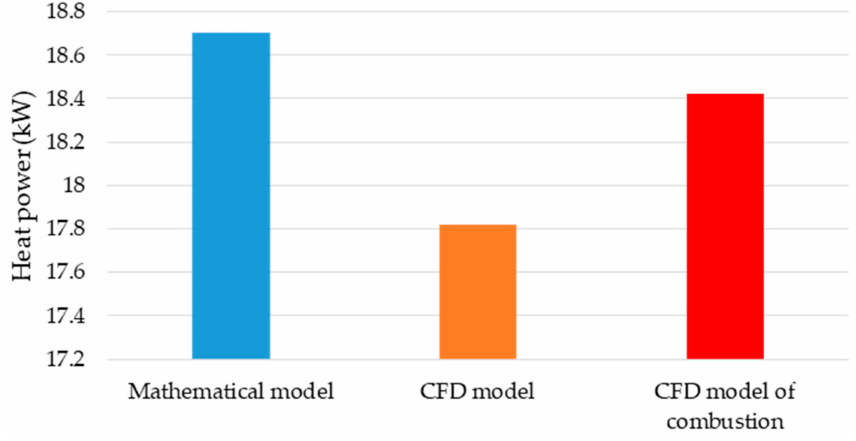
Figure 12. Comparison of calculated heat